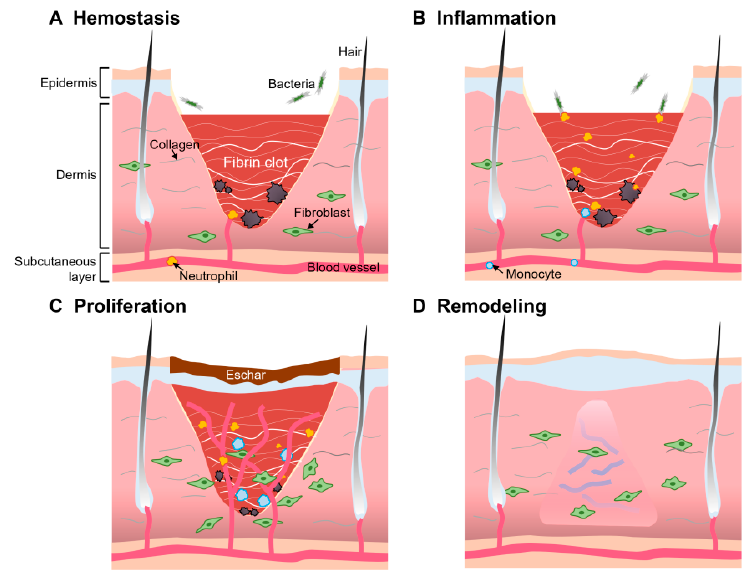
Figure 2. Four stages of wound healing. ( A ) Hemostasis; ( B ) inflammation; ( C ) proliferation; ( D ) remodeling. ( D )